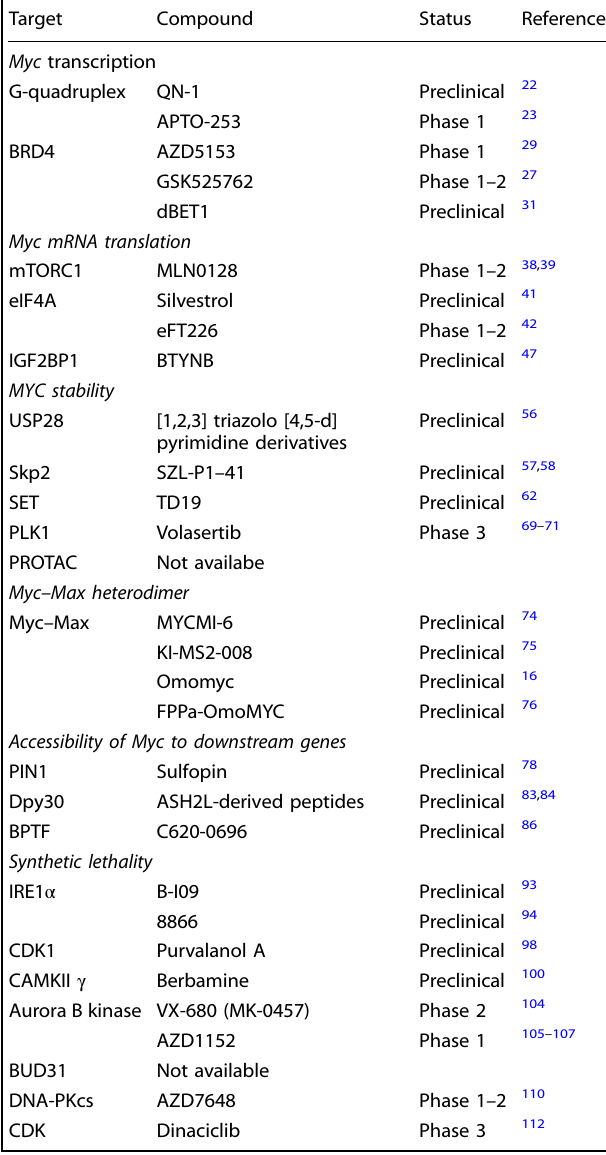
Table 1. Alternative nodes to target Myc through small molecules or